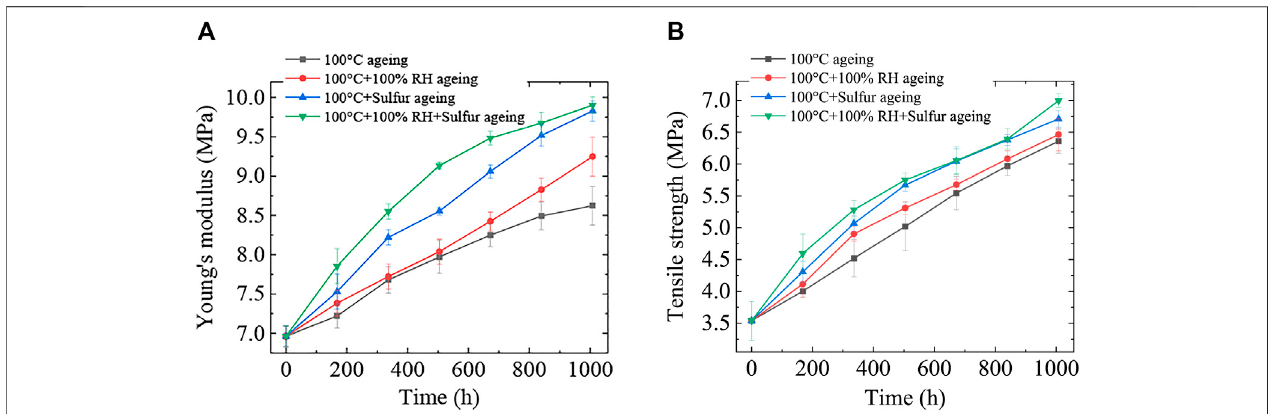
FIGURE 6 | Mechanical properties of four groups of samples vs. ageing time: (A) Young ’ s modulus; and (B) tensile strength.